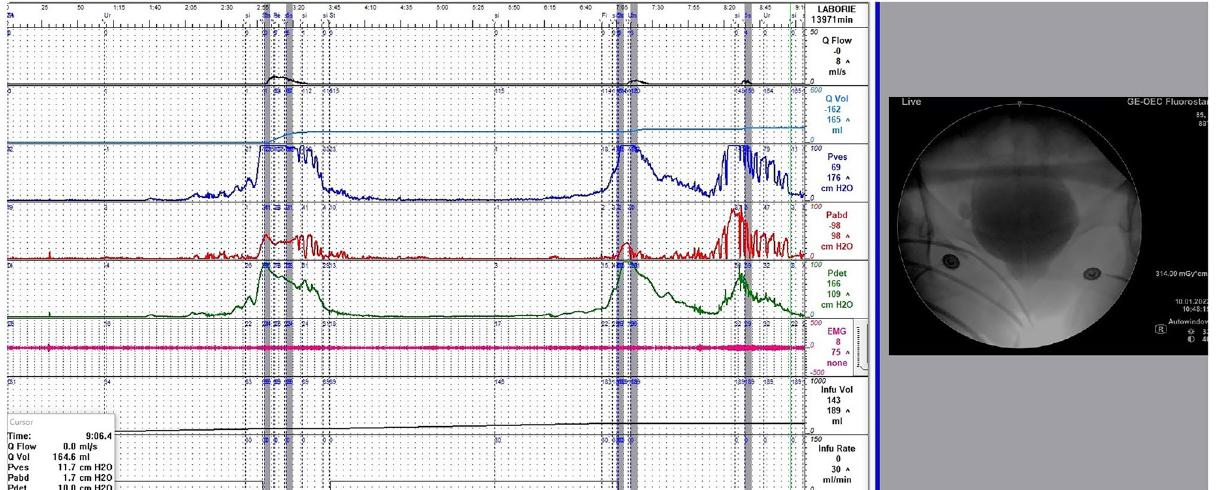
Figure 1. Videourodynamic study of dysfunctional voiding in a woman with an open bladder neck but a narrow membranous urethra (a spinning top appearance) on real-time fluoroscopy, increased urethral sphincter electromyography activities, a high detrusor pressure, and a low maximum flow rate during